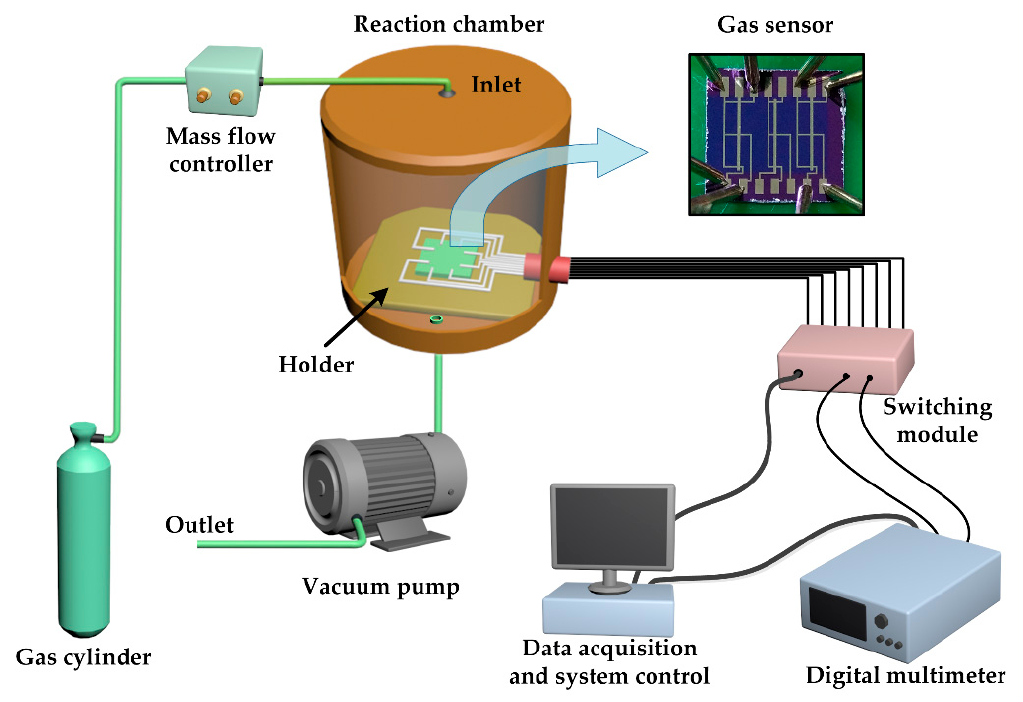
Figure 2. Schematic of the measurement setup.